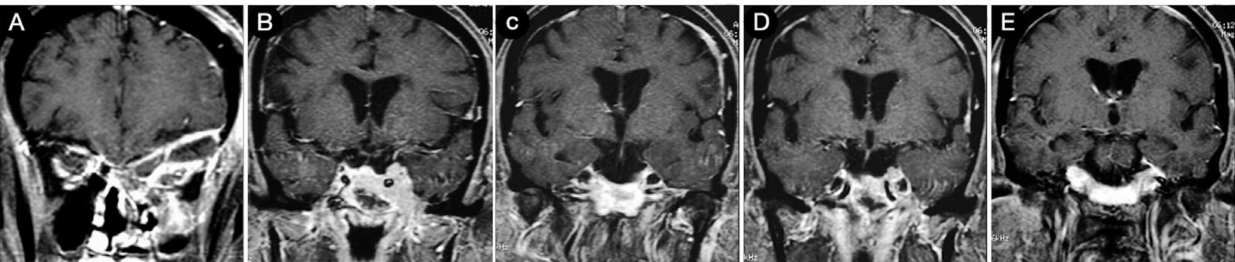
Figure 25. ( A – E ) Postoperative T1-weighted contrast-enhanced MRI. Scale bar: 5